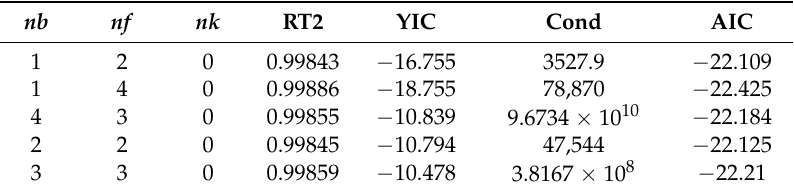
Figure 16. Input signal of the identification simulation. Table 8. Evaluation of the different model structures.